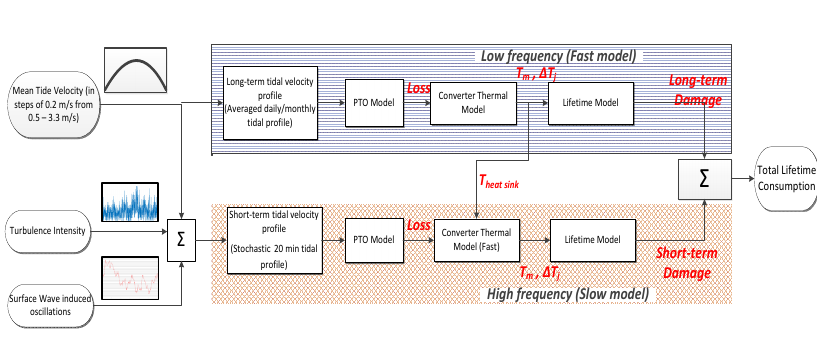
Figure 11. Methodology for lifetime calculations. Finer details of the power take-off (PTO) model are shown in Figure